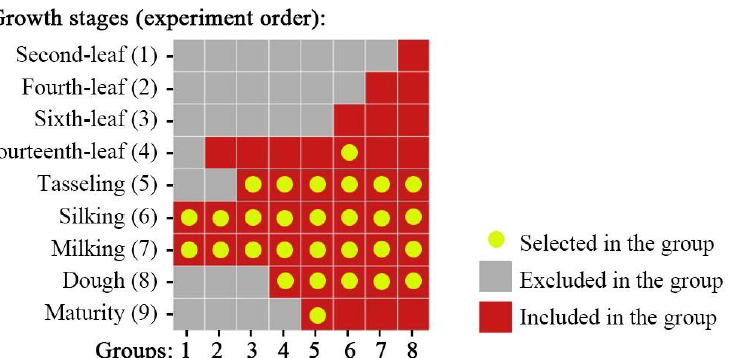
Figure 6. The compositions of the eight multi-temporal UAV datasets. (Red/grey denotes mono- temporal datasets are included/excluded in the multi-temporal datasets; yellow dots denote the selected mono-temporal datasets after feature variables screening, which was described in the following Section